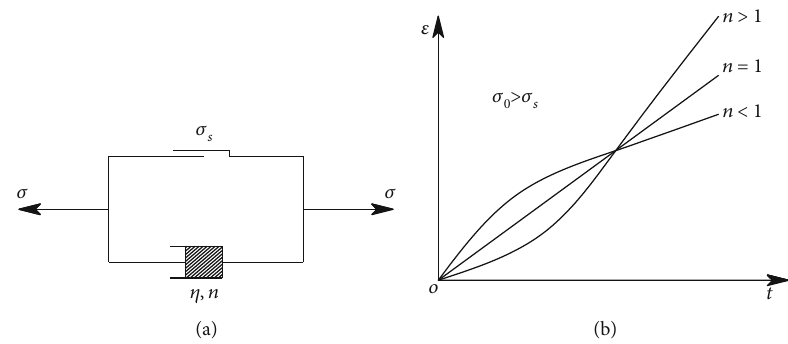
Figure 15: (a) Nonlinear viscoplastic body (NVPB). (b) Creep curve of the NVPB model.